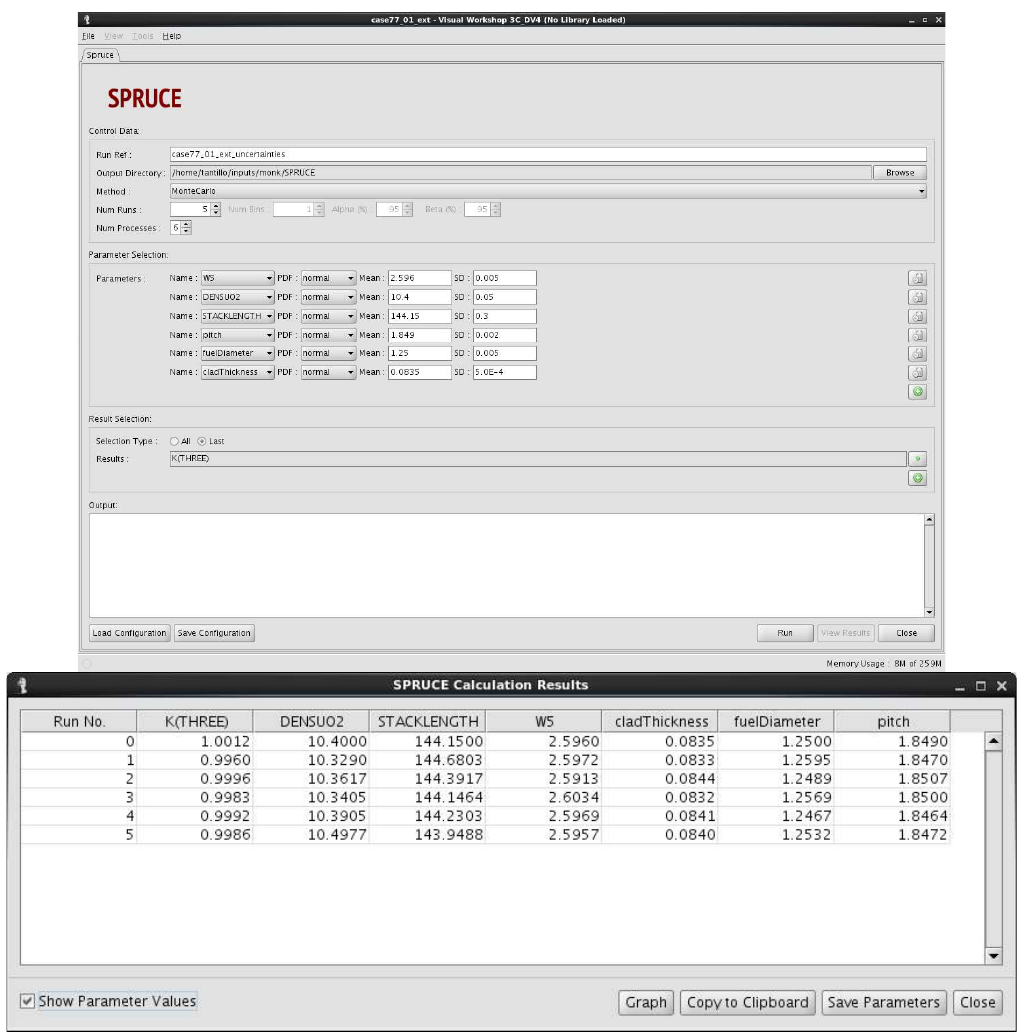
Figure 2. Visual Workshop Display Showing Sampling Input for Uncertainty Quantification and the Resulting